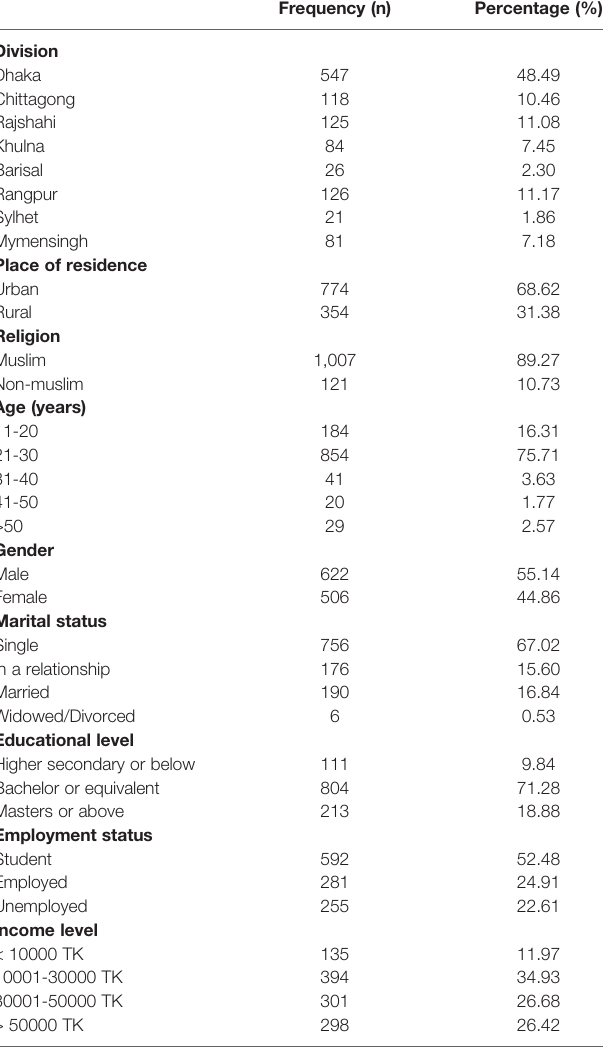
TABLE 1 | Distribution of the demographic